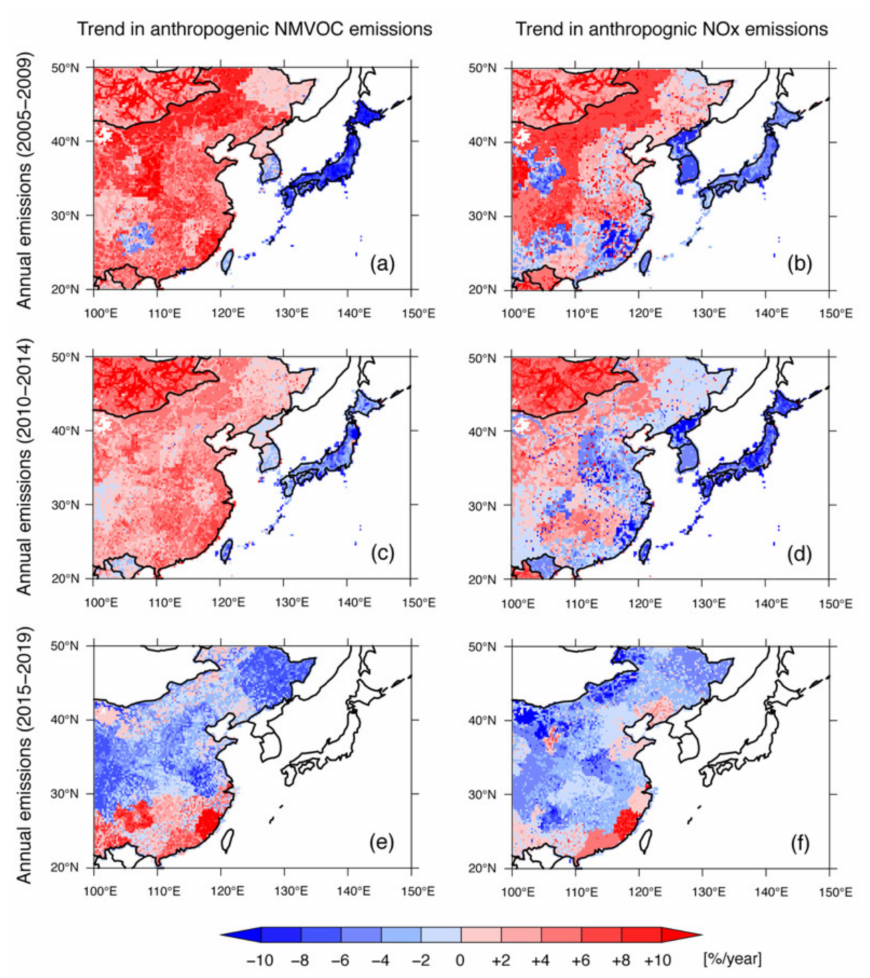
Figure 7. Linear regression analyses for the annual amount of ( a , c , e ) anthropogenic NMVOC emissions and ( b , d , f ) anthropogenic NO x emissions over East Asia during the 5-year periods of ( a , b ) 2005–2009, ( c , d ) 2010–2014, and ( e , f ) 2015–2019. White areas indicate no available